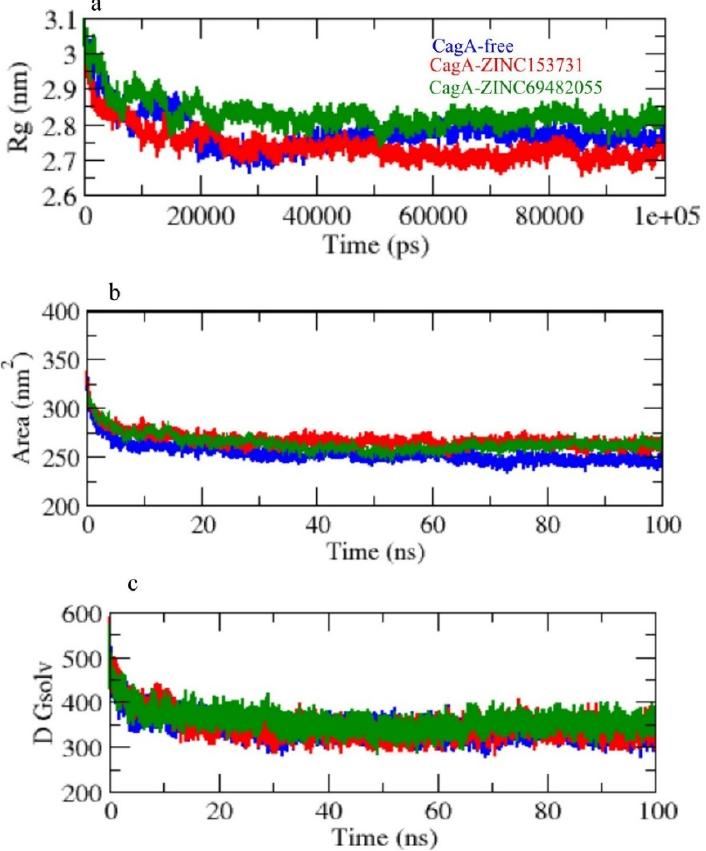
Figure 6. ( a ) Rg, ( b ) SASA, and ( c ) solvent free energy.